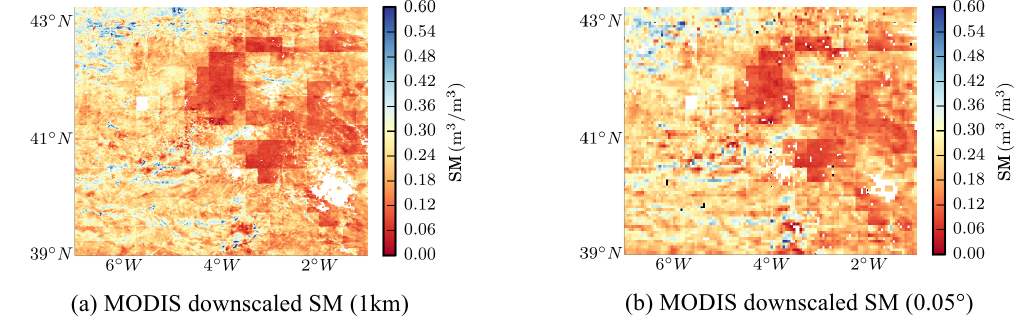
Figure 11. Spatial patterns of the downscaled soil moisture from MODIS at (a) 1km and (b) 0.05 ◦ spatial resolutions.